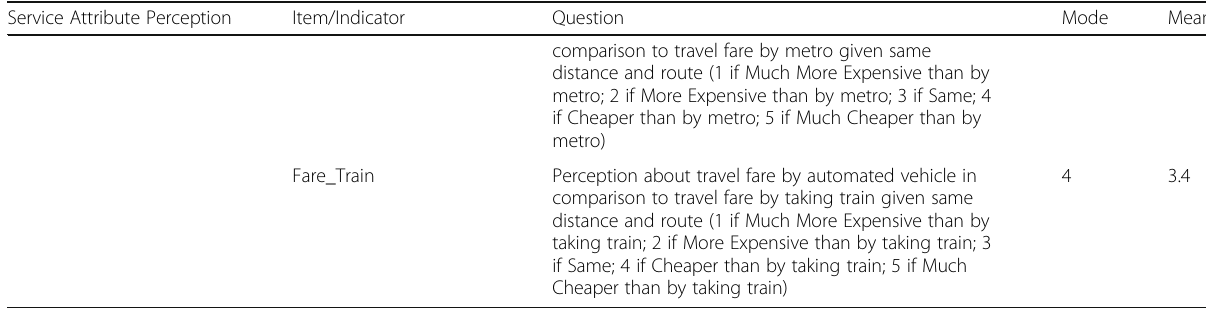
Table 2 Items/indicators for service attribute perception (Continued) Service Attribute